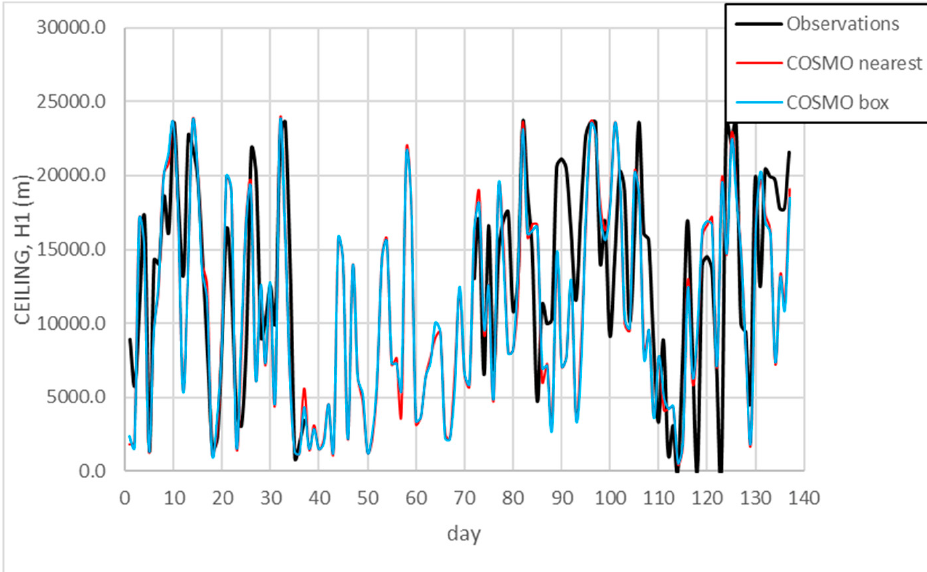
Figure 12. Time series of daily CEILING values (m) provided by the model against H1, provided by the ceilometer, over the considered period. (Note that in the period 21 February–26 March 2018 observational data were not available.)